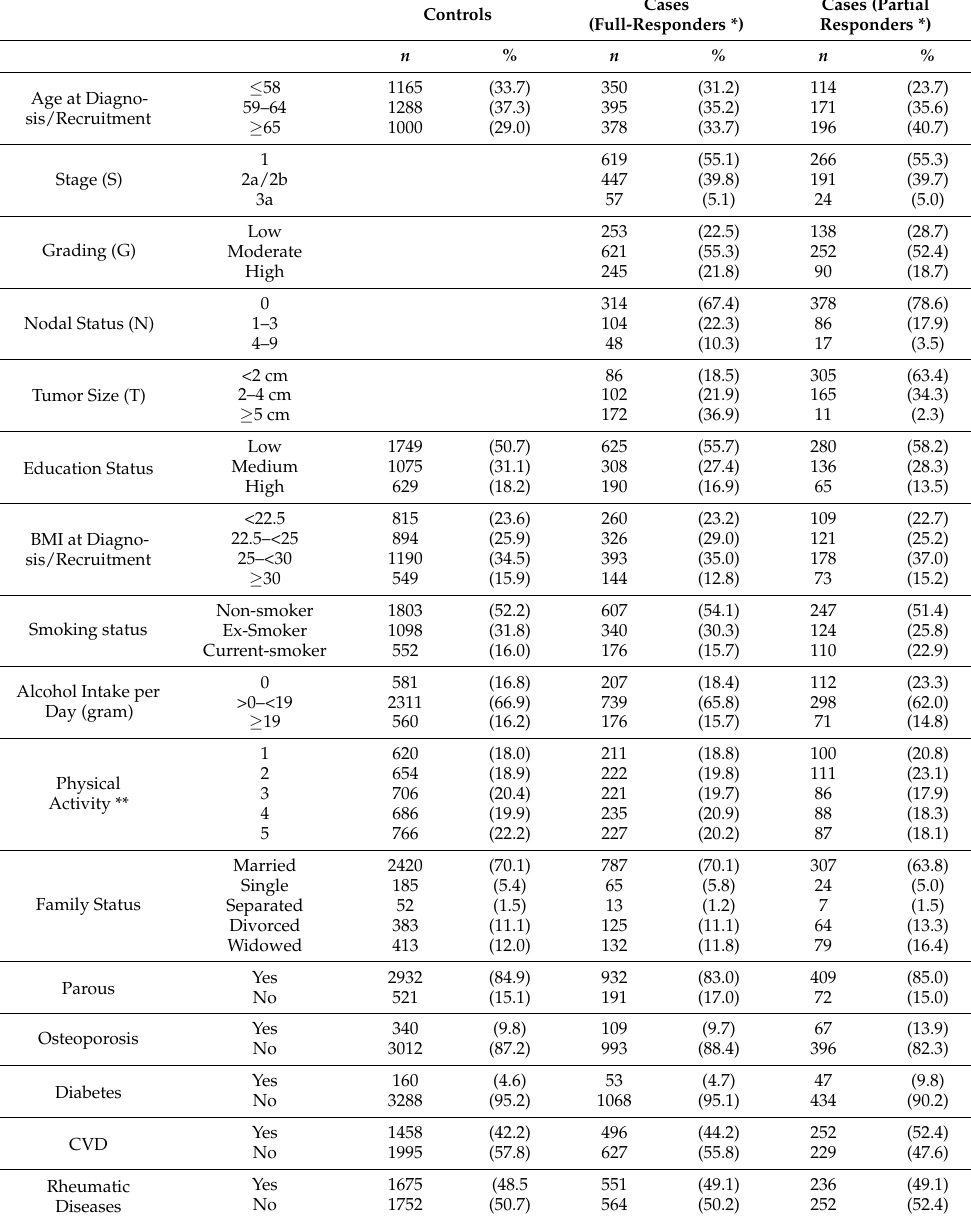
Table 1. Descriptive characteristics of cases, controls and partial responders